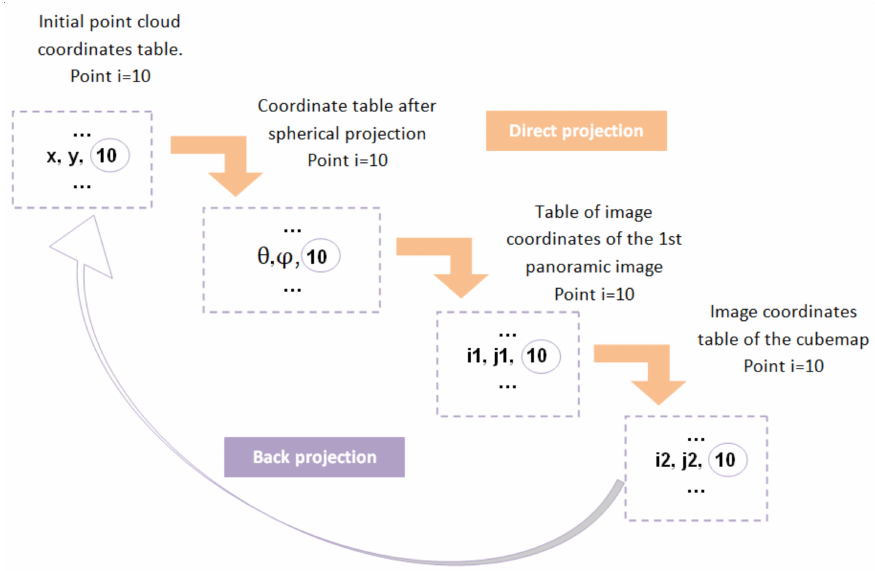
Figure 17. Diagram of the link between the different coordinates tables allowing the back projection of the point with the identifier